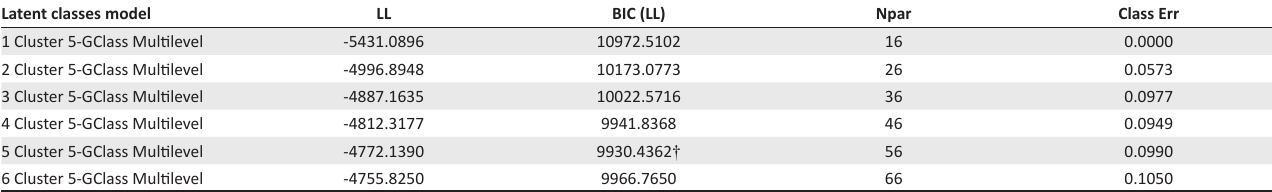
TABLE 8: Latent class model prediction